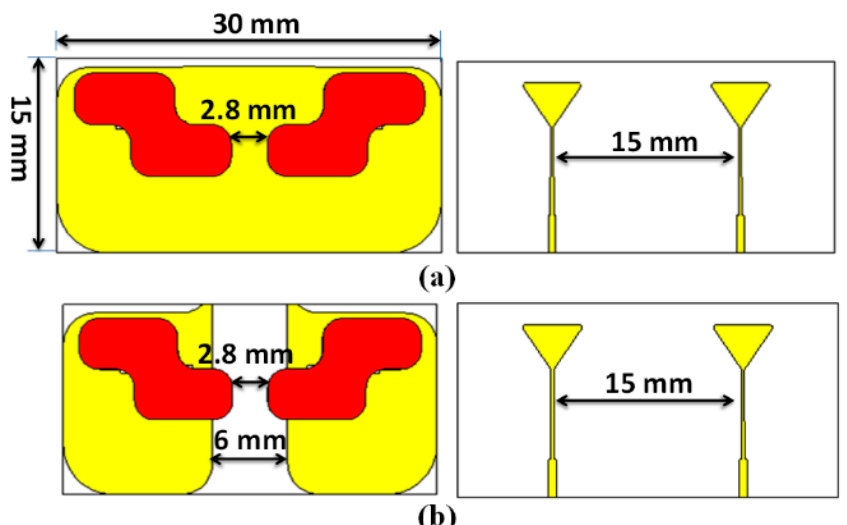
Table 1. Performance of a two-port antenna.